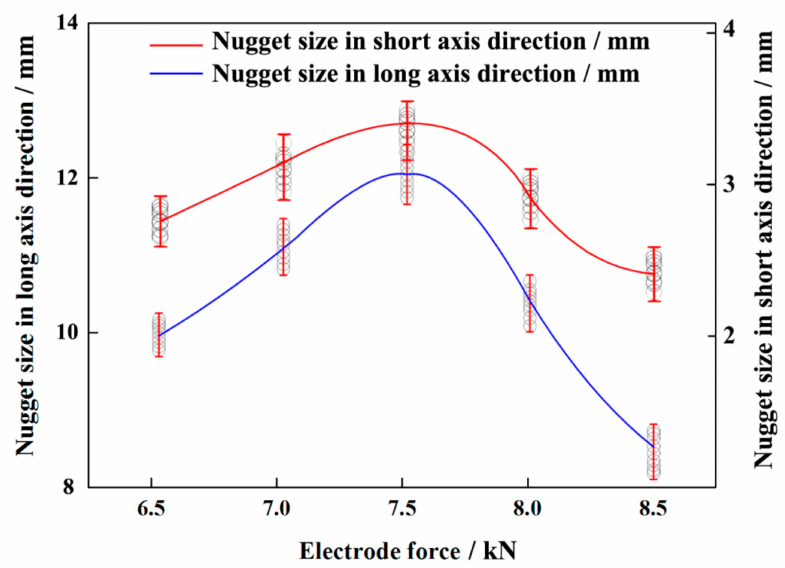
Figure 12. Influence of welding pressure on the dimensions of